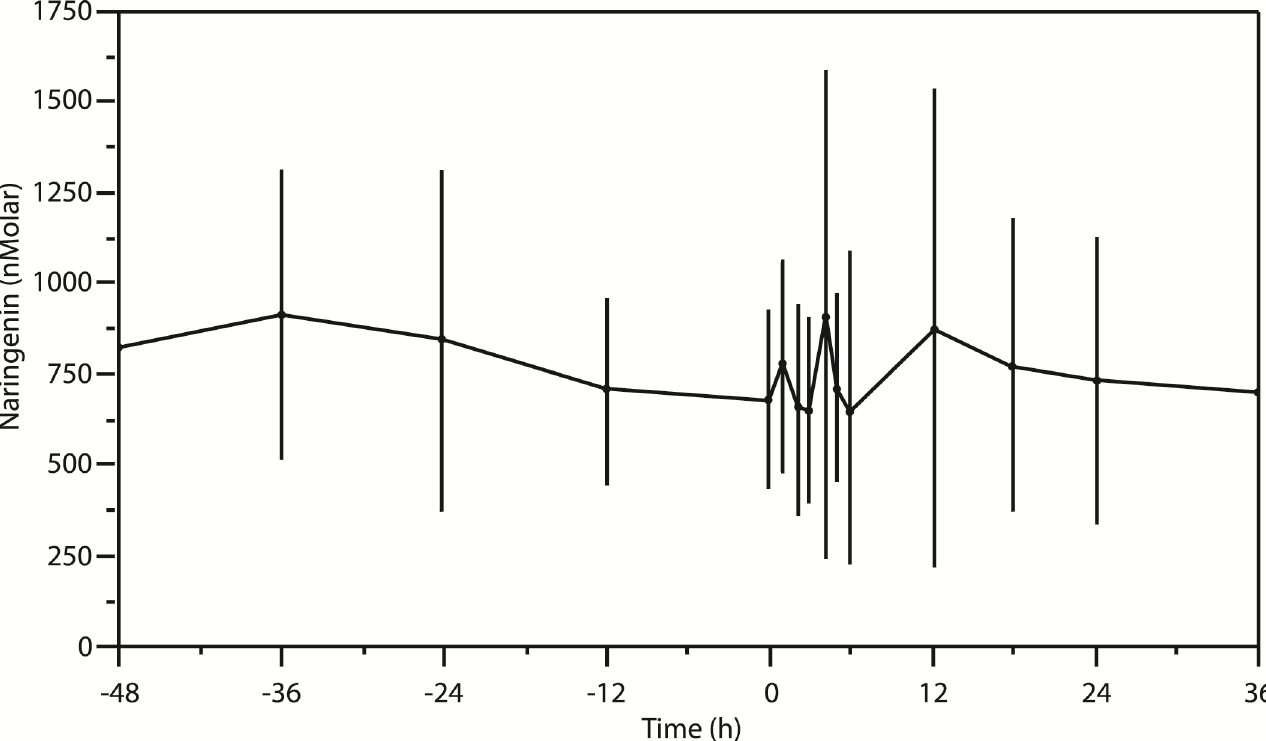
Fig 1. Mean naringenin concentrations in human milk. Friedmantest (N = 10, df = 14) = 18.903p = 0.169.